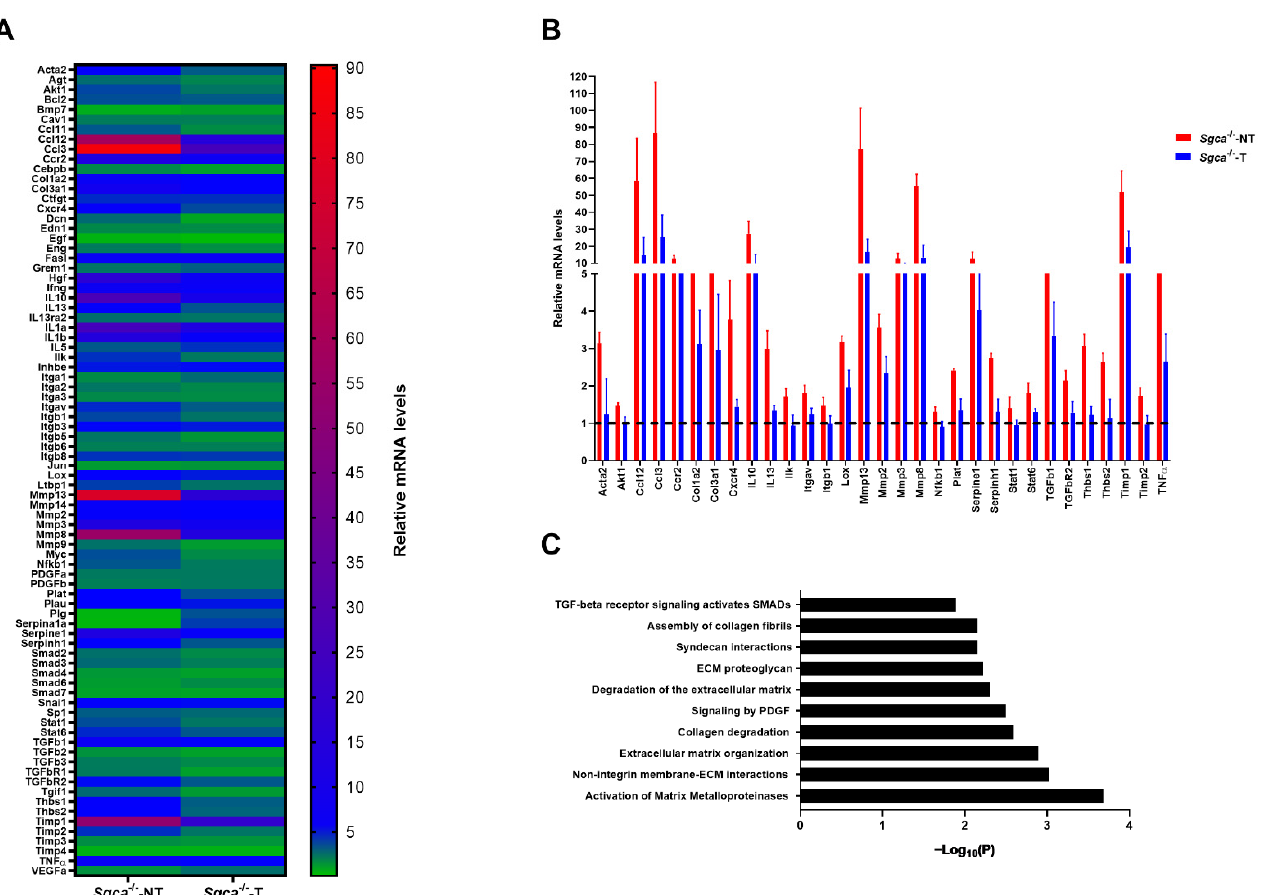
Figure 3. Nintedanib reduces gene expression of fibrosis-related genes in muscle. ( A ) Heatmap of relative mRNA expression of 84 analyzed genes. The color gradient represents the relative ∆∆ Ct value. ( B ) Schematic representation of the overexpressed genes in the Sgca -/- mice that are significantly reduced after treatment with nintedanib. ( C ) Schematic representation of Reactome ® pathways that are significantly reduced in nintedanib-treated mice. Genetic background mouse strain C57BL ( Wt ); n = 3, no-treated Sgca -/- mice (Sgca -/- -NT), n = 4; nintedanib-treated Sgca -/- mice (Sgca -/- -T), n = 4. Data are expressed as means ± SD and Tbp gene was used as endogenous control.